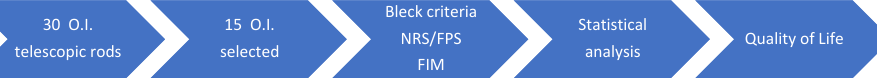
Figure 1. Flow-chart of the study methodology.